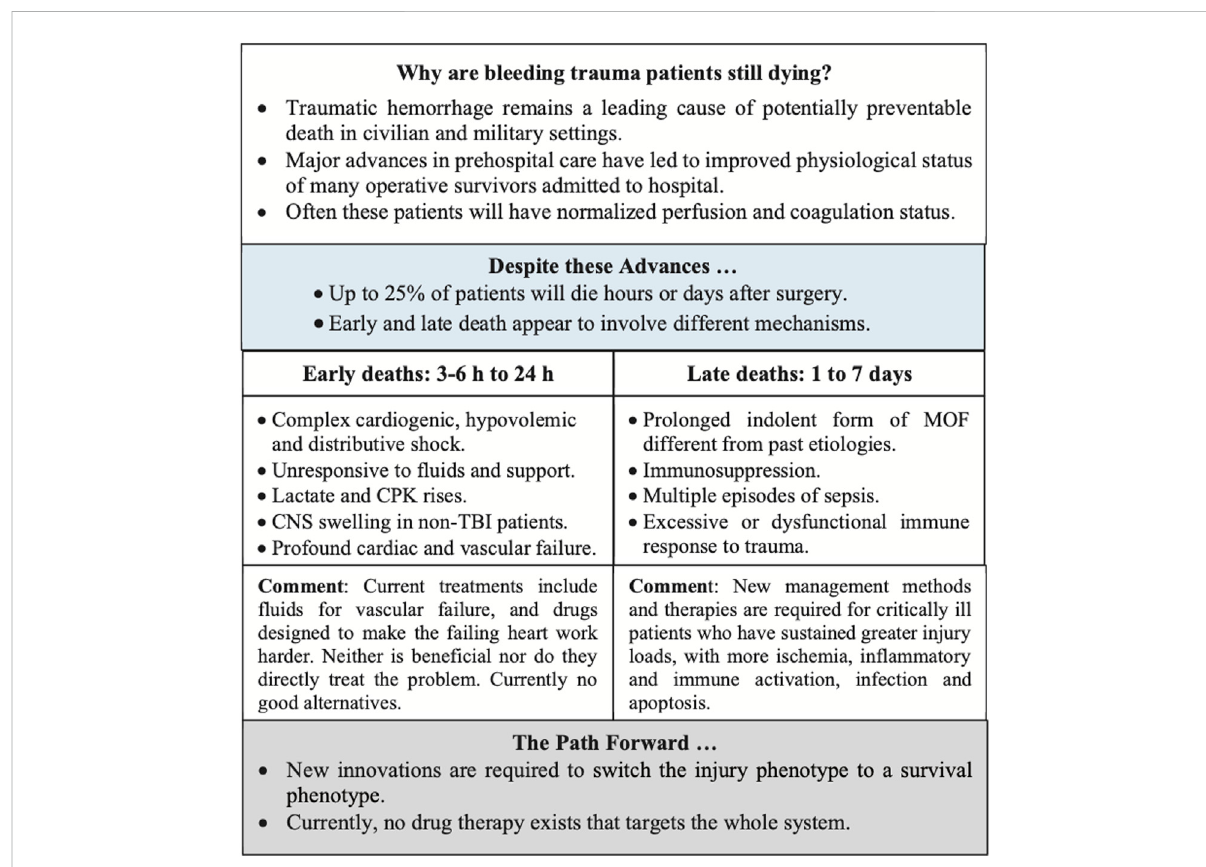
FIGURE 1 Summary of the characteristics of early and late deaths after traumatic hemorrhage modi fi ed after Brohi and colleagues (Brohi et al., 2019). Patients who died at the point-of-injury or in the fi rst few hours upon arrival to hospital have not been included. CNS, central nervous system; CPK, creatine phosphokinase; MOF, multiple organ failure; TBI, traumatic brain